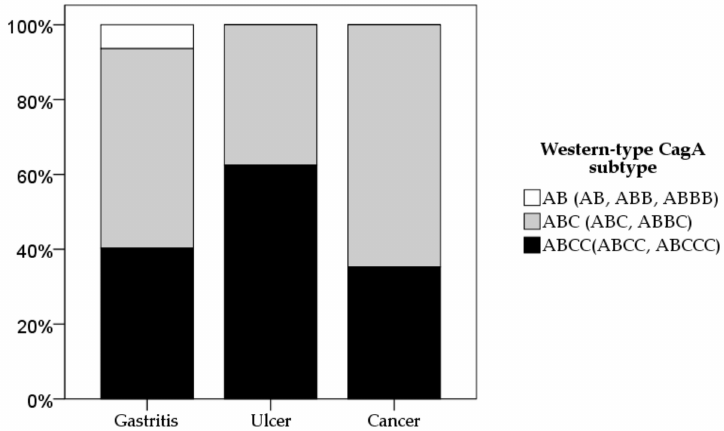
Figure 2. Western-type CagA subtyping based on diseases. The distribution of Western-type CagA subtypes based on disease groups are